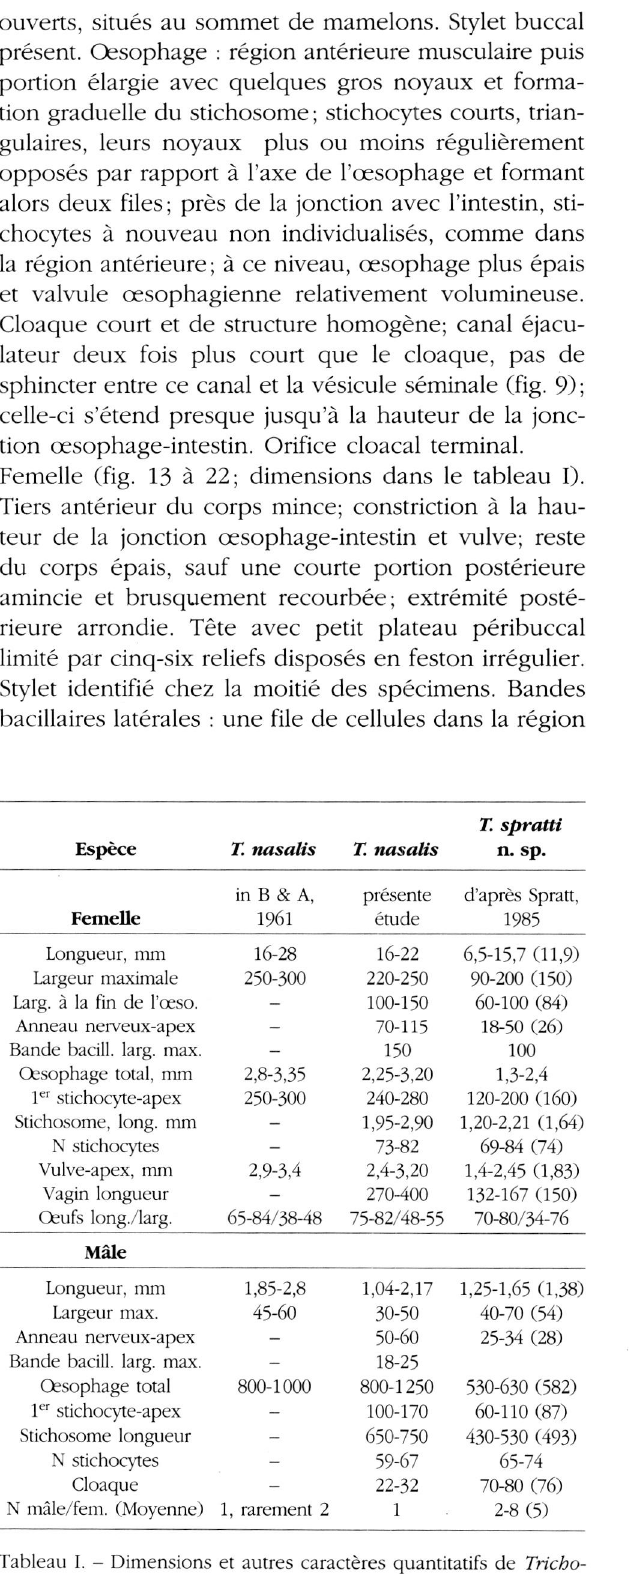
Tableau I. - Dimensions et autres caractères quantitatifs de Tricho somoides nasalis chez R. norvegicus en Italie d'après Biocca &